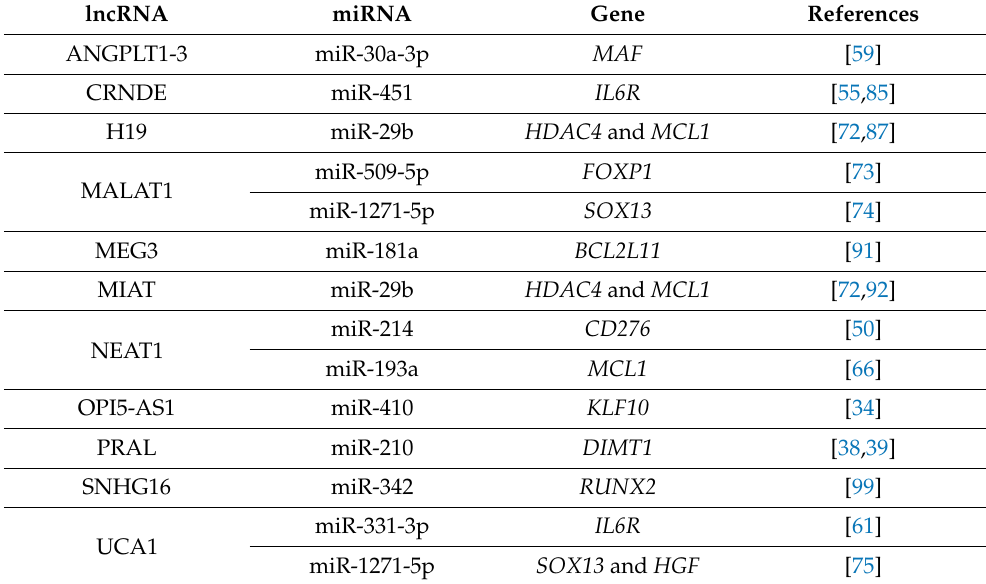
Table 3. Genes dysregulated in MM due to overexpression of ceRNA